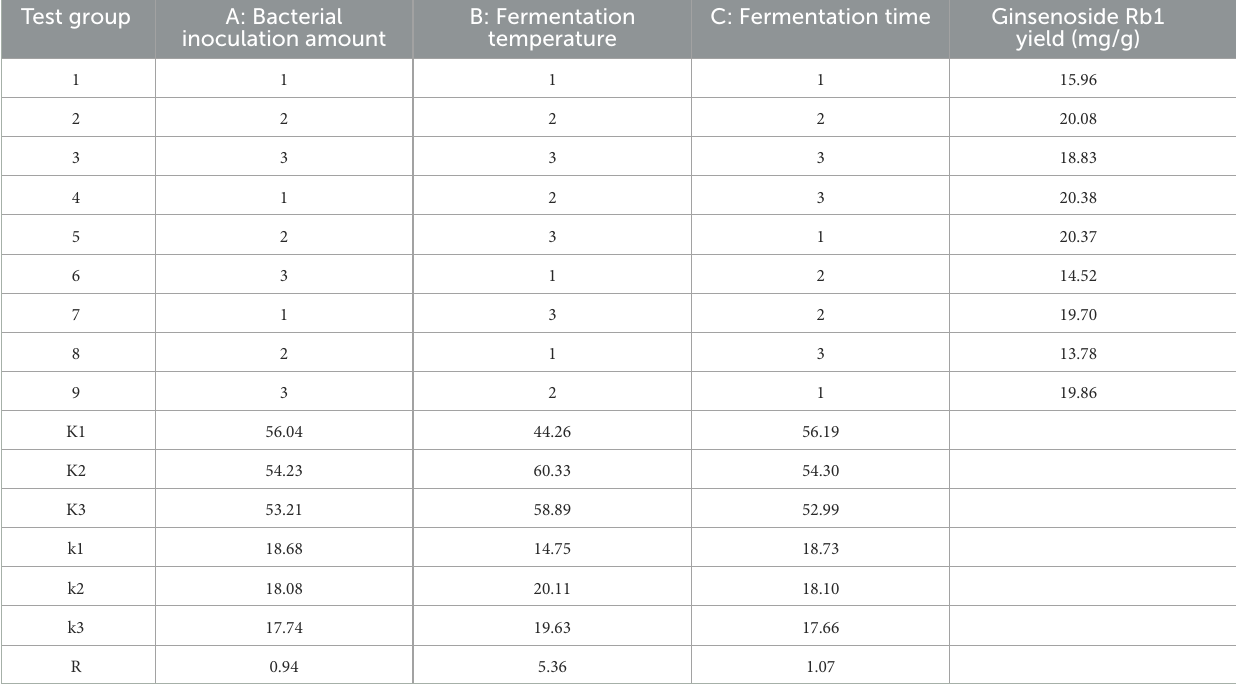
TABLE 2 Orthogonal experimental design and